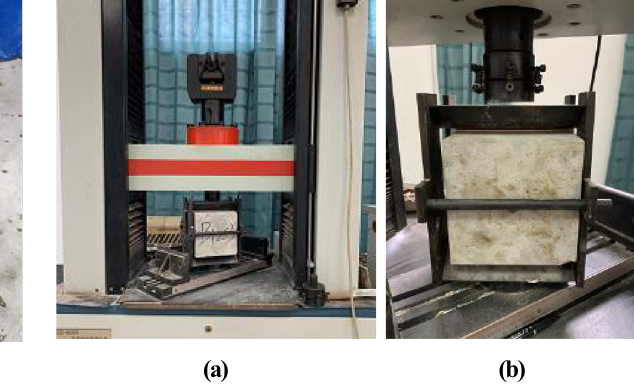
Figure 3: Slump test: ( a ) fi lling slump cylinder and ( b ) testing the slump.